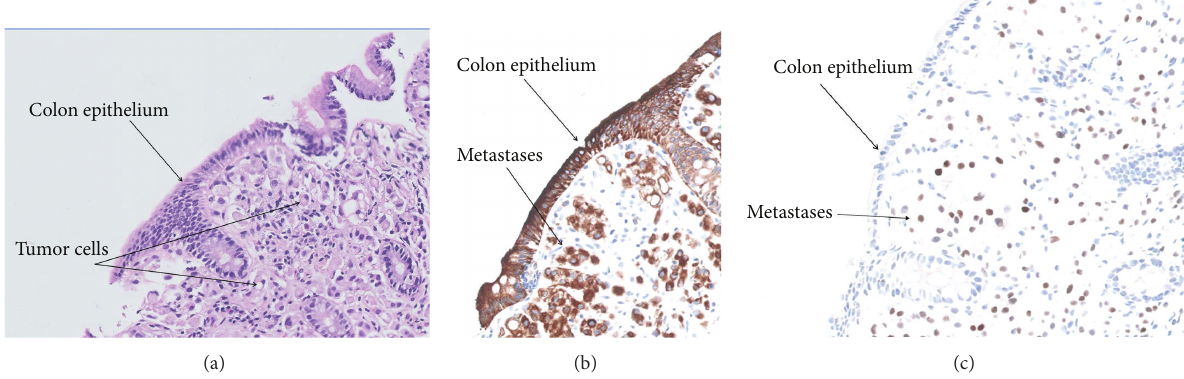
Figure 2: Histopathological examinations of colon biopsies reveal metastases of lobular breast carcinoma. (a) Haematoxylin-eosin (HE) staining, magnification 20x, (b) immunohistochemical staining for keratin, magnification 20x, and (c) immunohistochemical staining for oestrogen receptor, magnification